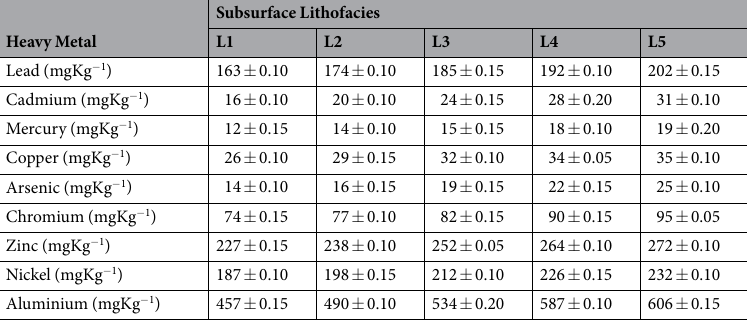
Table 1. Heavy metals distribution over the lithofacies of the subsurface